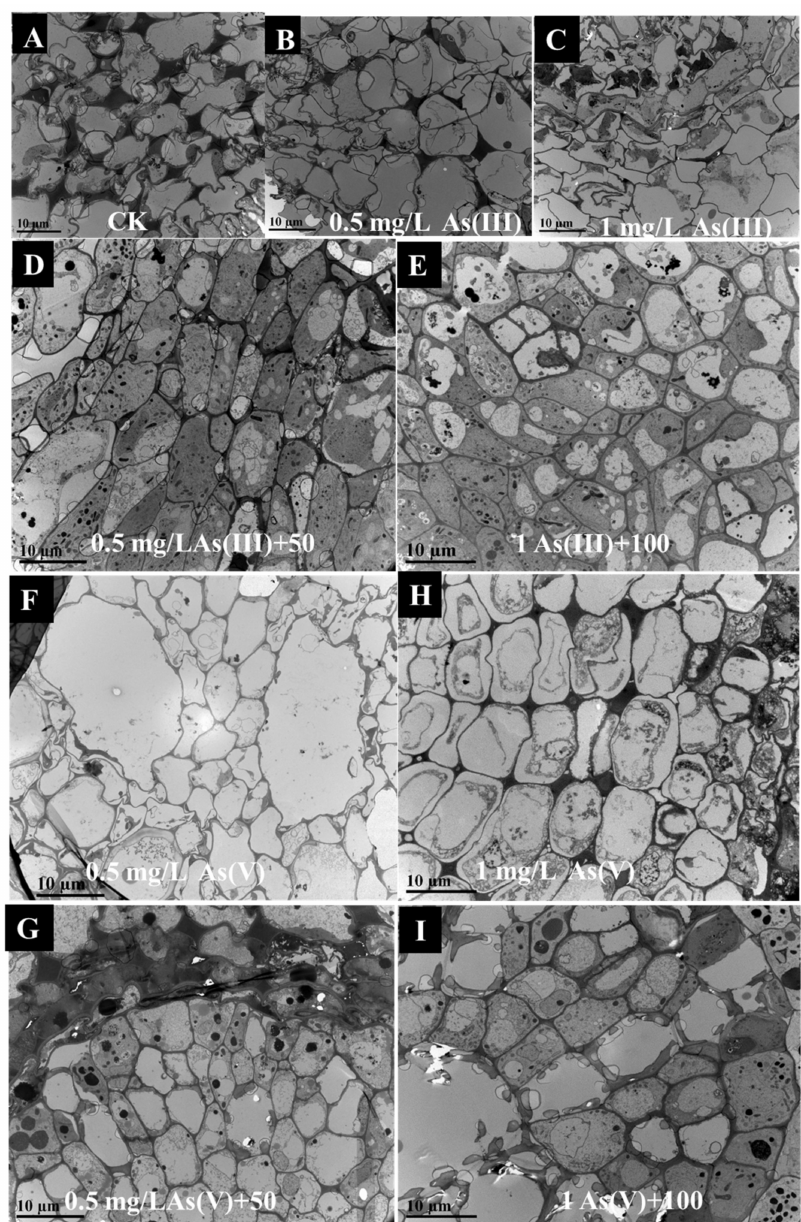
Figure 3. TEM images of root cells under of the CK ( A ), 0.5A ( B ), 0.5A+50 ( C ), 1A ( D ),